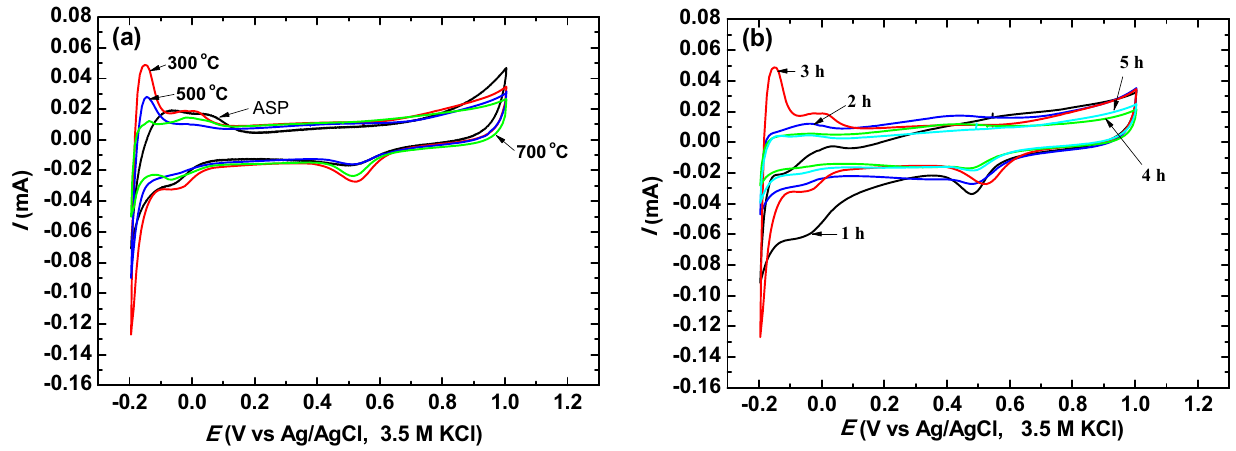
Fig. 3 CV of PdNi/C catalysts calcined a at different temperatures and b at 300 (cid:3) C for different times